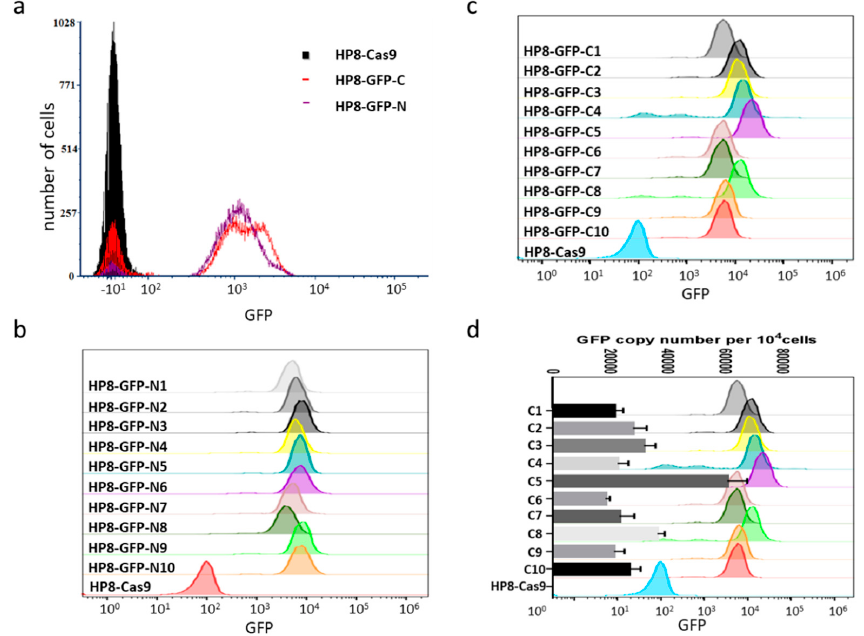
Figure 5. GFP expression in HP8-Cas9 cell line. ( a ) fluorescence-activated cell sorting (FACS) analysis of GFP expression on HP8 cells with GFP inserted in pp38 locus at N (HP8-GFP-N) and C (HP8-GFP-C) terminus. ( b ) FACS analysis of GFP expression on expanded population of 10 single cell clones of HP8-GFP-N after two weeks incubation. Fluorescence intensity varies between di ff erent clones. ( c ) FACS analysis of GFP expression on expanded population of 10 single cell clones of HP8-GFP-C after two weeks incubation. Fluorescence intensity varies between di ff erent clones. ( d ) GFP copy number per 10 4 cells was measured on 10 single cell clones of HP8-GFP-C by q-PCR and plotted against the GFP fluorescence intensity measured by FACS analysis. The chicken ovotransferrin gene was used for calculation of GFP copies per 10 4